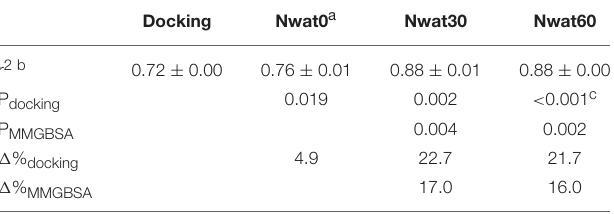
TABLE 1 | ROC AUC values obtained at different scoring conditions for AmpC β